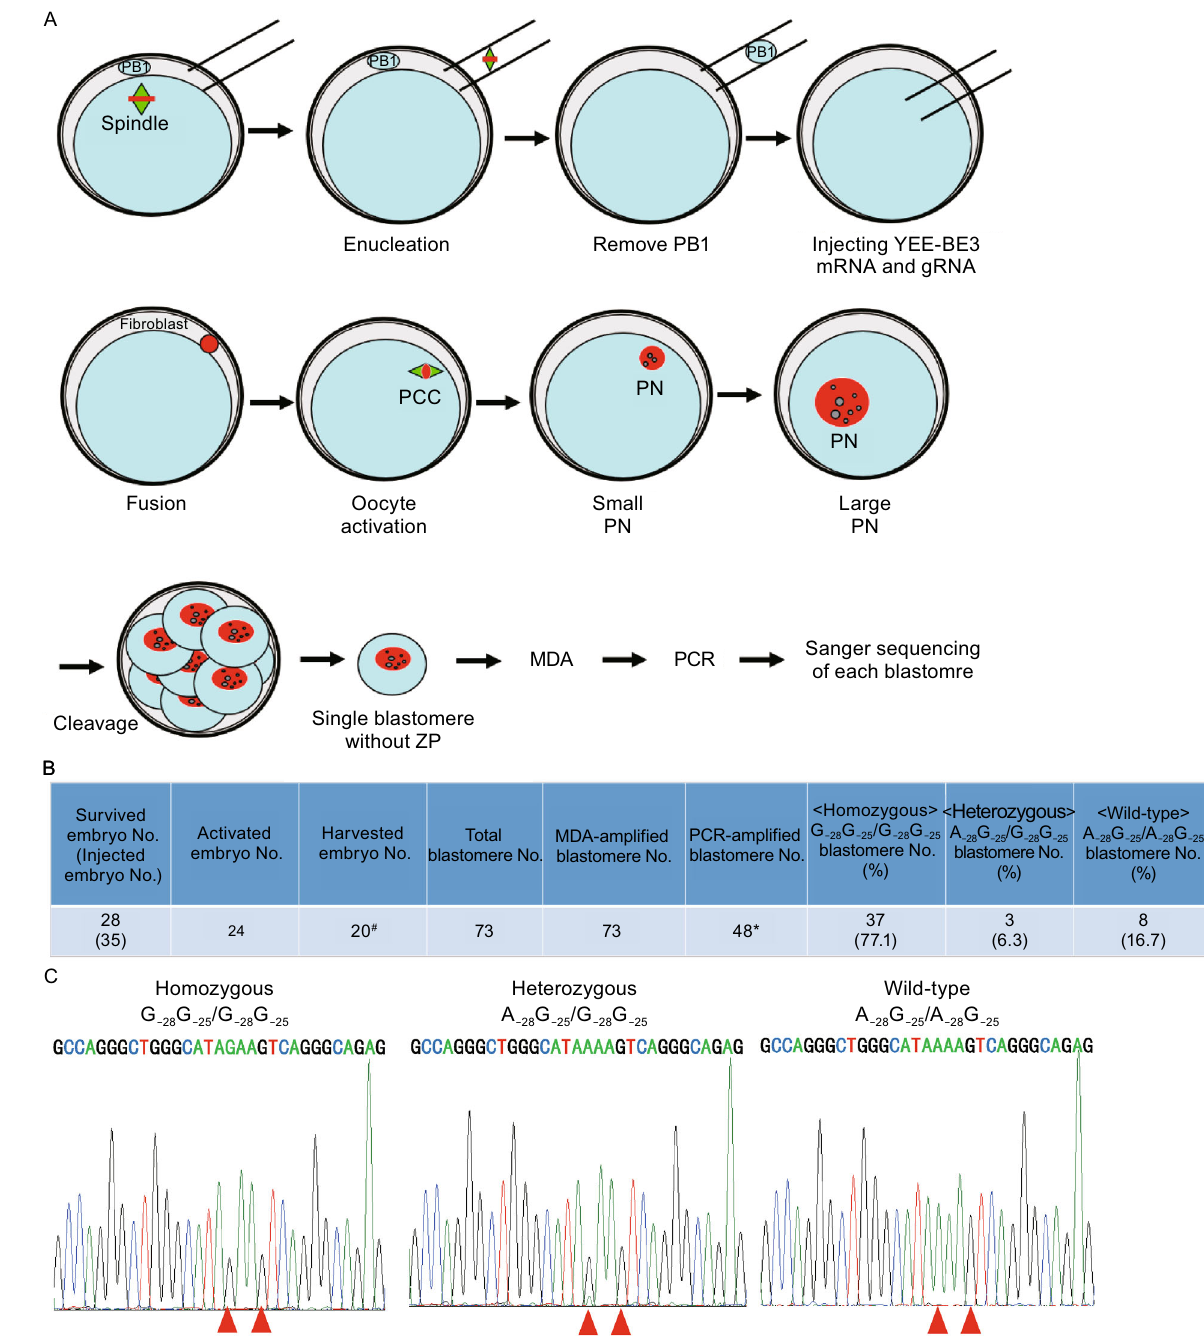
Figure 4. Improving the precision of gene correction in human embryos by YEE-BE3. (A)Schematicofrepairing HBB − 28(A>G) inclonedhumanembryosbyYEE-BE3andgRNA-1.Firstly,cloned HBB − 28(A>G)mutanthomozygoushumanembryosweregenerated by fusing skin fi broblast cell from the patient with in vitro matured oocytes. And YEE-BE3 mRNA and gRNA mixture was injected after removingPB1.And1hlater,theinjectedoocyteswerefusedwithskin fi broblastcells.Thenthefusedembryoswereactivatedandcultured for another 48 h. Single blastomere was isolated and MDA ampli fi ed. Then HBB site was ampli fi ed and sequenced. PB1, the 1st polar body. PN, pronucleus. ZP, zonapellucida. (B) Summary of base editing-mediated point mutation repairing by YEE-BE3 in cloned human embryos. The numbers of homozygous mutant blastomere (G − 28 G − 25 /G − 28 G − 25 ), heterozygous blastomeres (A − 28 G − 25 /G − 28 G − 25 ), and wild-type blastomeres (A − 28 G − 25 /A − 28 G − 25 ) were calculated. #, 4 embryos did not develop into 2-cell stage. *, HBB site failed to be ampli fi ed by PCR. (C) Sanger sequencing to detect successful repairing by YEE-BE3 in each blastomere. Representative sequencing chromatographs of homozygous mutant blastomeres, heterozygous blastomeres and wild-type